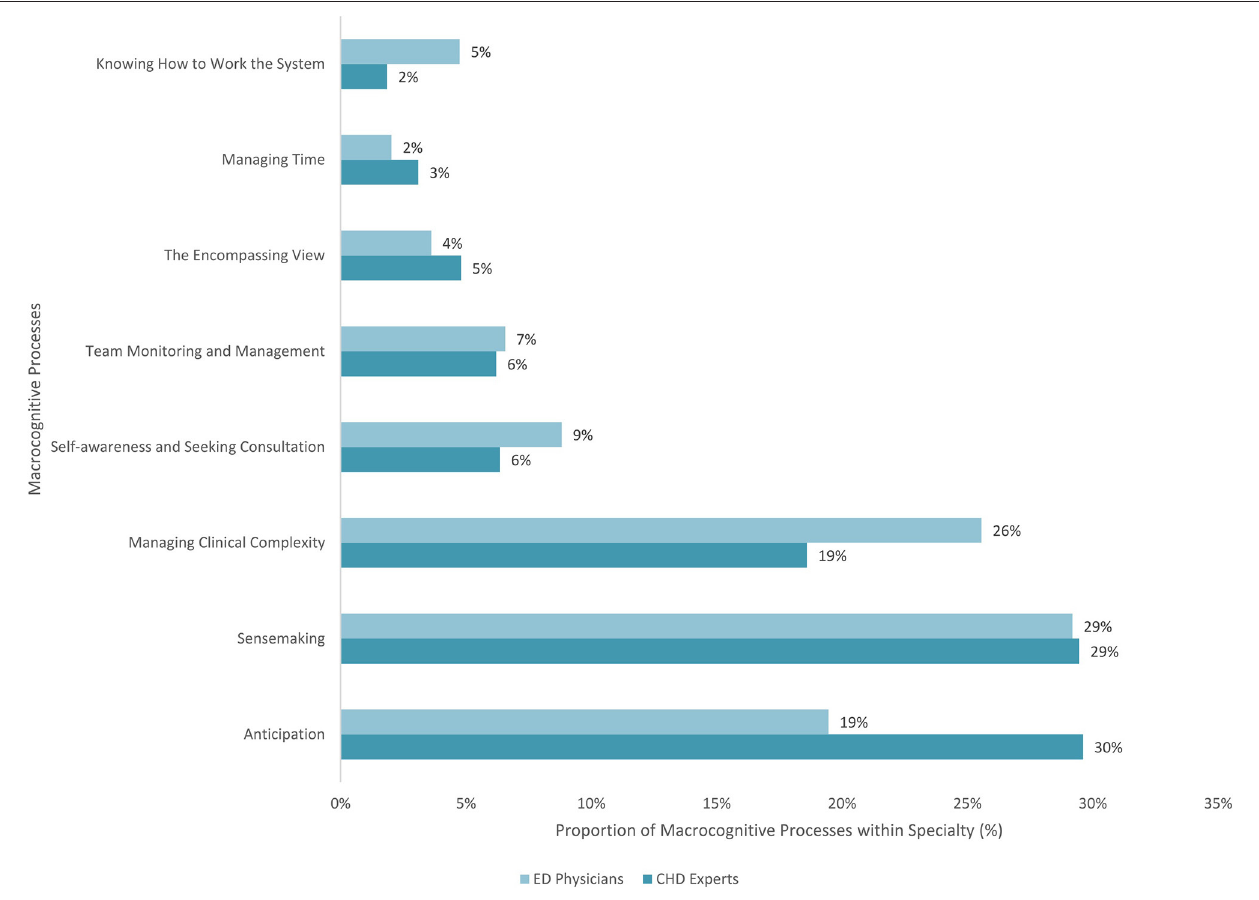
FIGURE 1 | Distribution by number of verbal references and percentages of macrocognitive processes for CHD experts and ED physicians.